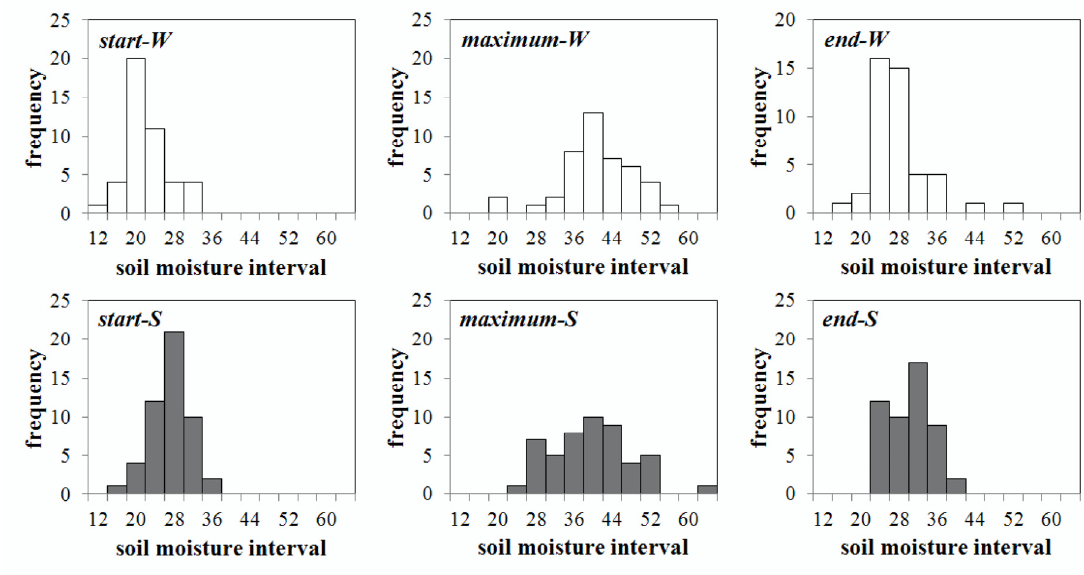
Figure 3. The probability density function (PDF) of soil moisture during rainfall for WaterNET (at top) and SoilNET (at bottom). “start”, “maximum” and “end” refer to